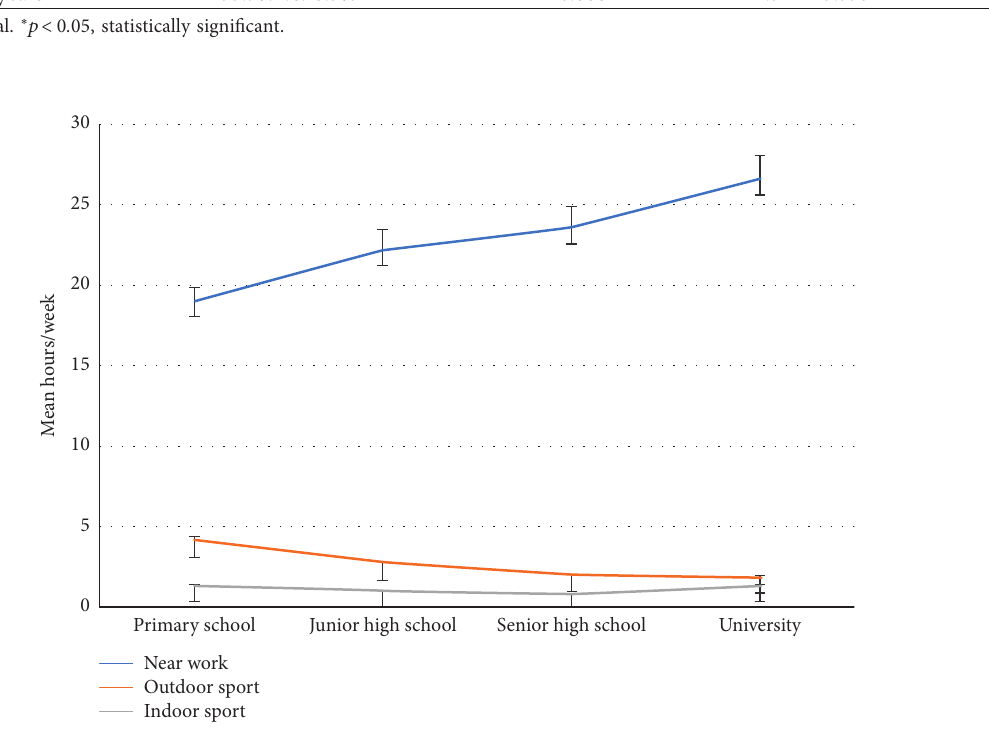
Figure 2: The mean of the time utilized in engaging in near work, outdoor sports, and indoor sports in four different educational stages. The time utilized in engaging in work that requires close eye concentration of near work showed a significant positive linear trend ( p < 0 . 001), and outdoor sports showed a significant negative linear trend ( p < 0 . 001). The time of indoor sports showed the lowest time at all four stages. Error bars indicate 1 standard deviation (SD). Table 3: Comparison between high myopia and non-high